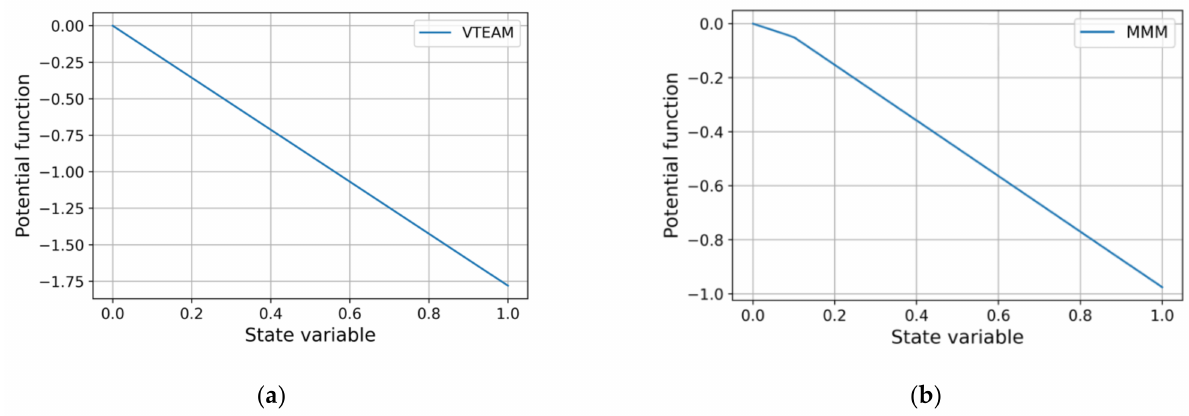
Figure 10. Potential functions of models with optimal parameter values: ( a ) VTEAM; ( b )